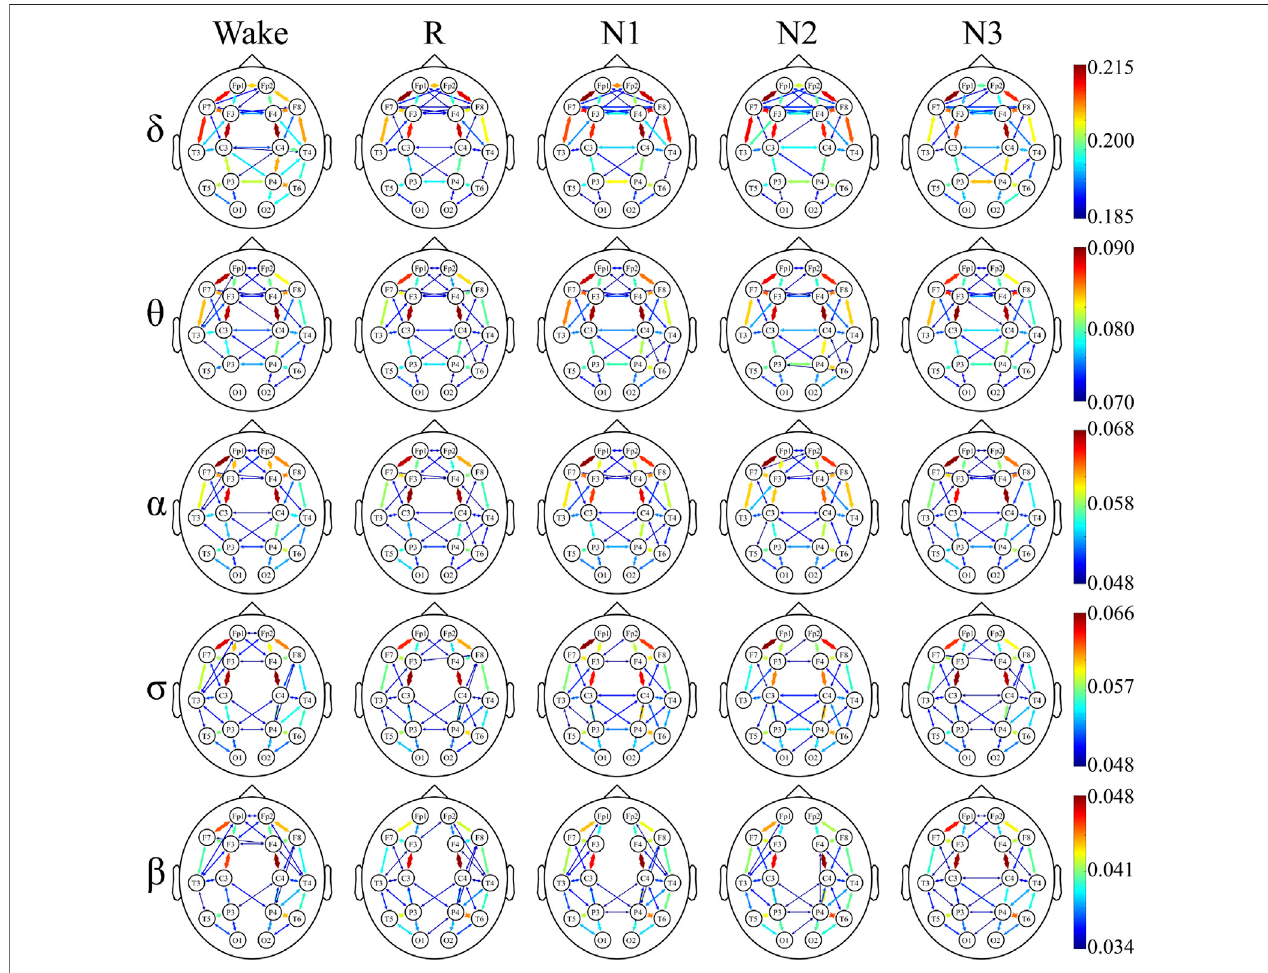
FIGURE6| Undirectedconnectivitygraphs ofthe depressed group. Redindicates ahigher link value.No linkindicates thatthere isno direct functional connection between the two sites.